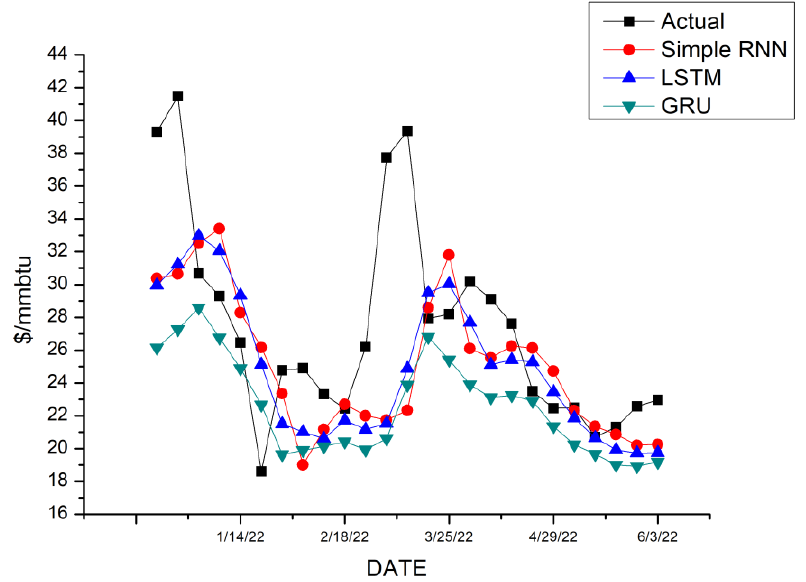
Figure 4. Prediction of LNG bunker price by each method. RNN, recurrent neural network; LSTM, long short-term memory; GRU, gated recurrent unit.